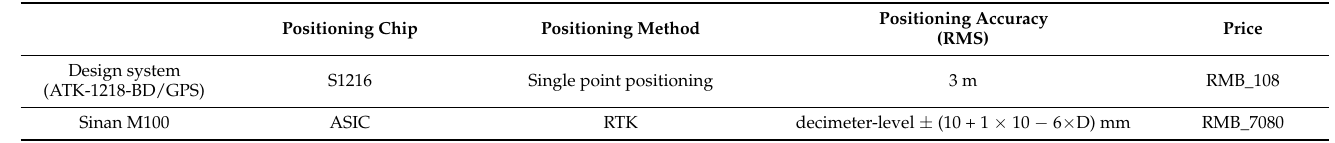
Table 3. The comparison of key parameters for ATK-1218 -BD/GPS and